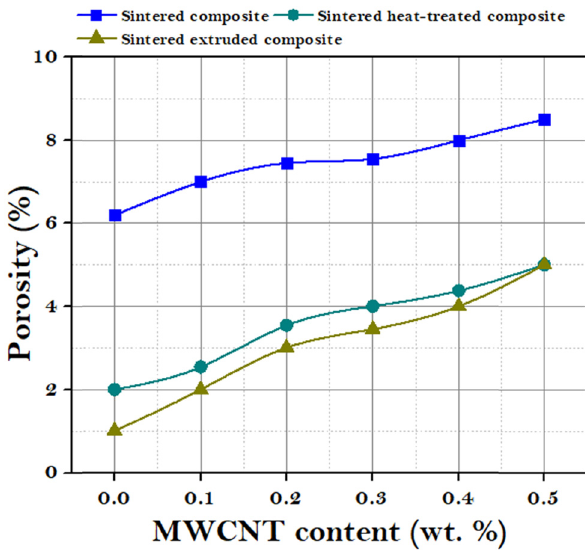
Figure 7: Porosity of the composites with varying weight percen - tages of